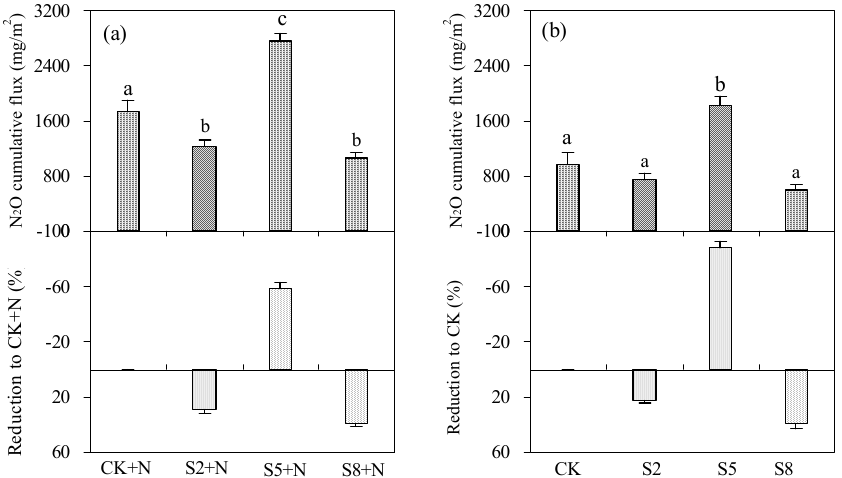
Figure 6. Cumulative N 2 O fluxes from saline water irrigated soils and its reduction rates compared to fresh water irrigated soils. ( a ) represent cumulative N 2 O fluxes from S2 + N, S5 + N, and S8 + N soils and its reduction rates compared to CK + N soils. ( b ) represent cumulative N 2 O fluxes from S2, S5, and S8 and its reduction rates compared to CK soils. Different letters on each bar represent significant difference in N 2 O emissions at p < 0.05 level. S2, S5, and S8 represent soils irrigated with water at 2, 5, and 8 g/L salinity level; S2 + N, S5 + N, and S8 + N represent soils irrigated with water at 2, 5, and 8 g/L salinity level and nitrogen fertilization (120 kg N/ha) application. CK + N and CK represent fresh water irrigated soils with or without nitrogen fertilization (120 kg N/ha) application, respectively.